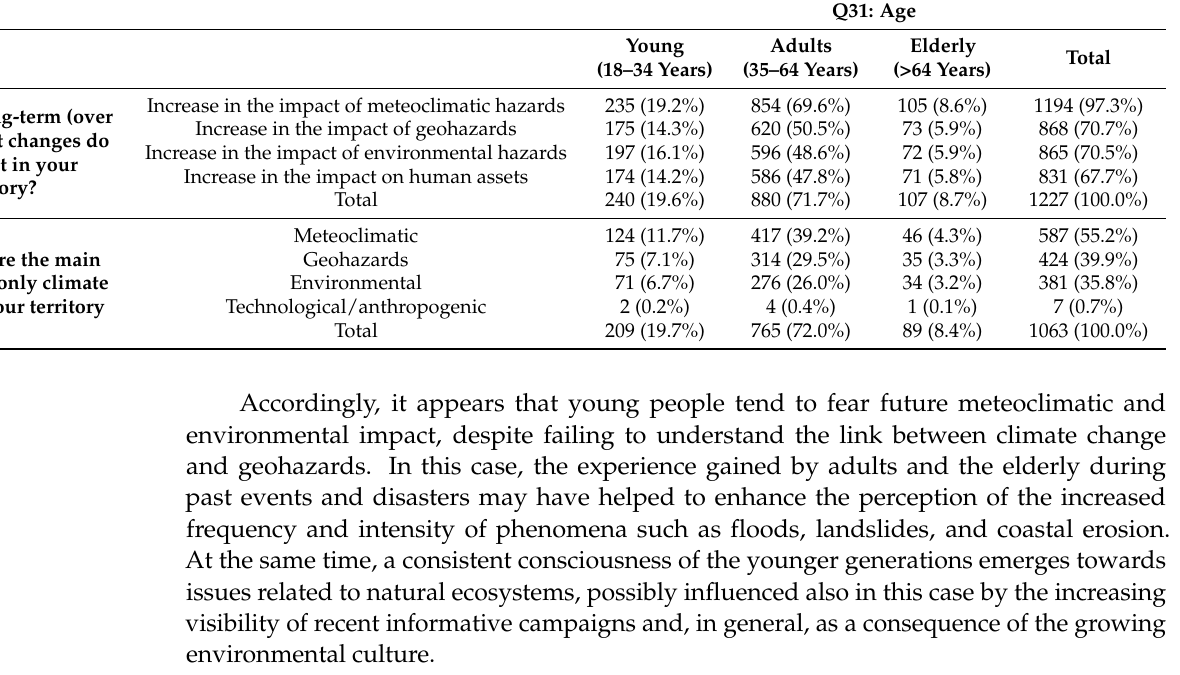
Q31: Age Young Adults Elderly (18–34 Years) (35–64 Years) (>64 Years)